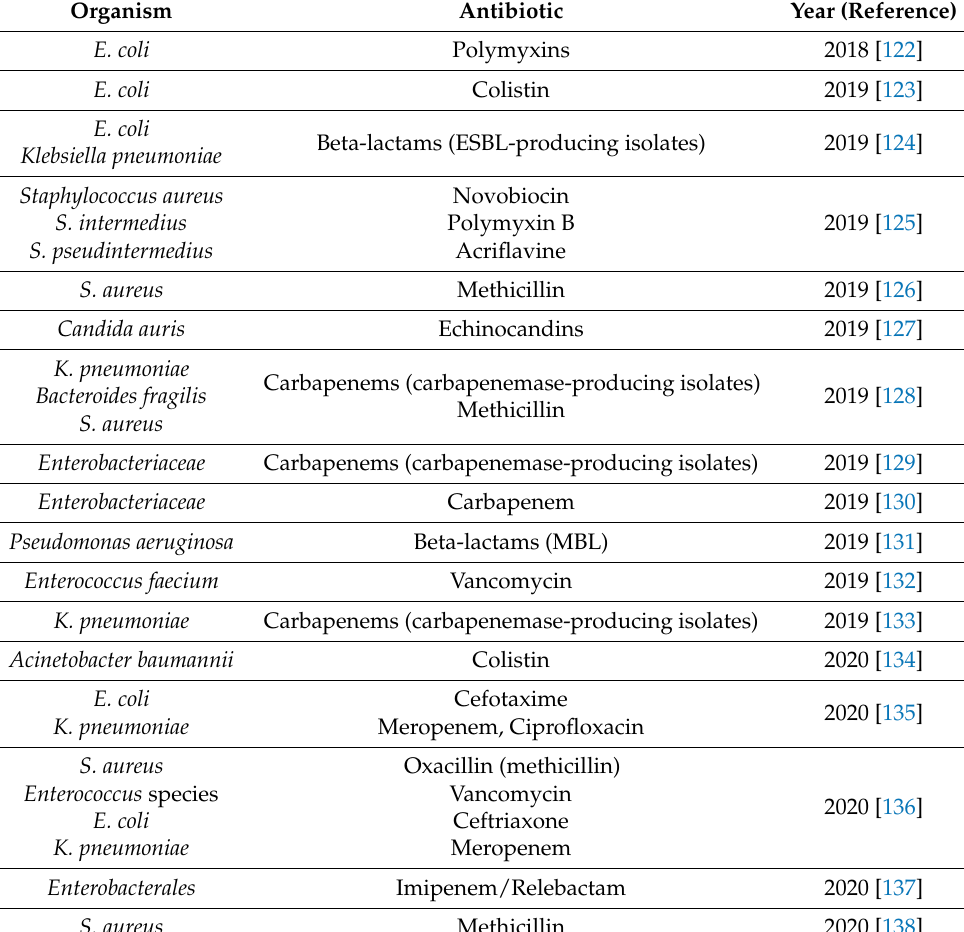
Table 2. Applications of MALDI-TOF MS for specific antimicrobial resistance (AMR) detection.